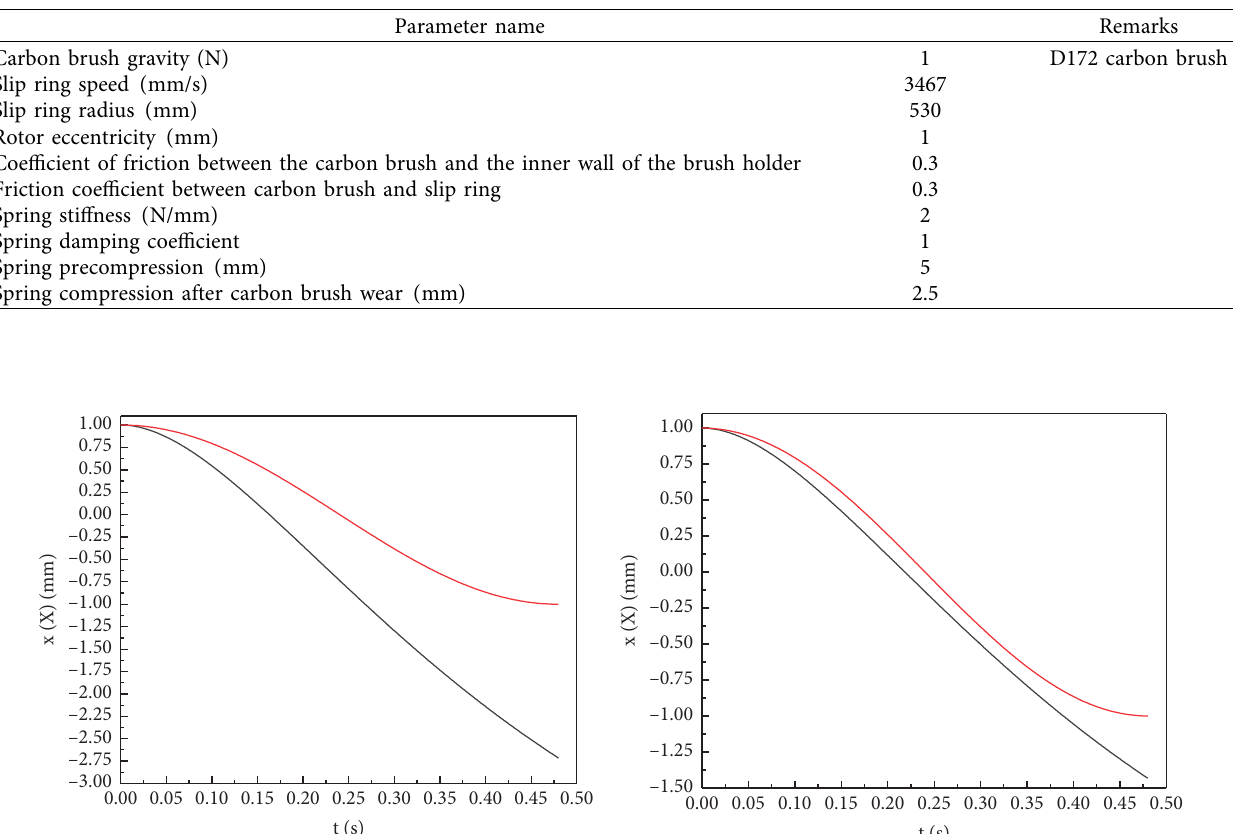
Table 3: Carbon brush/slip ring parameter table.